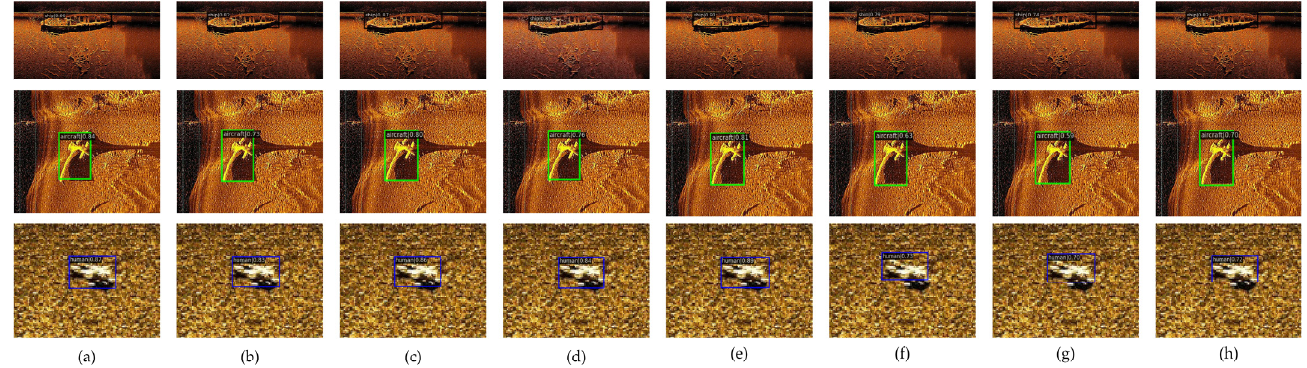
Figure 8. Comparison of DP-ViT and other methods in side-scan sonar dataset ( a ) our method:DP-ViT ( b ) Faster R-CNN (Resnet50) ( c ) Faster RCNN (Resnet101) ( d ) Sparse R-CNN (resnet50) ( e ) Sparse R-CNN (resnet101) ( f ) Next ViT ( g ) YOLOX-s ( h ) YOLOv3 DPFIN. Table 3. Figure 7 Schematic test results.